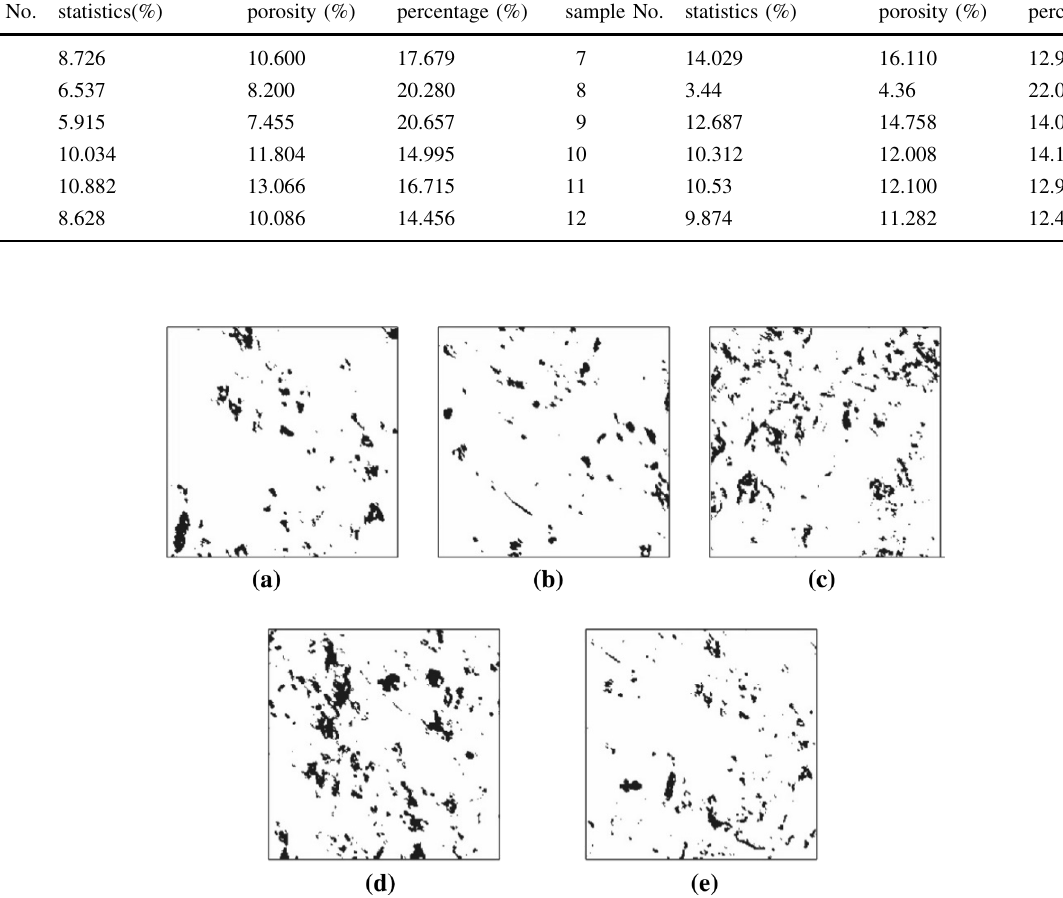
Table 3 Comparison of digitally calculated (at 1000 9 magnification) and experimentally measured average porosity Coal Average porosity sample No. statistics(%)